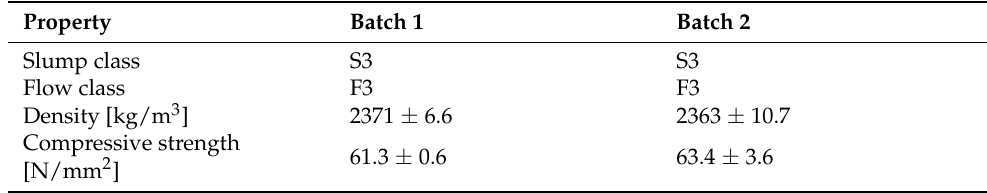
Table 2. Properties of concrete